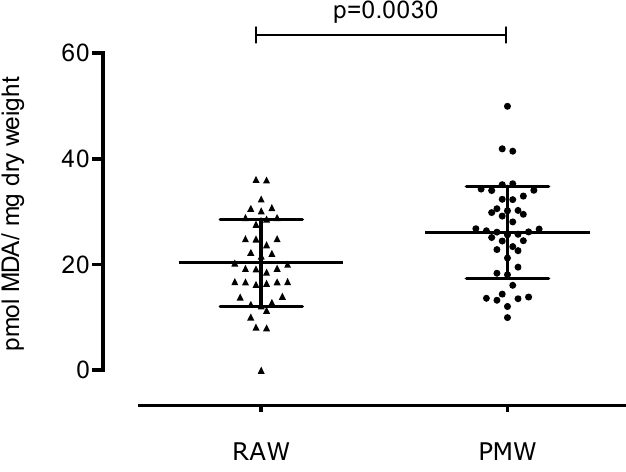
Figure 3. Levels of malondialdehyde (MDA) in reproductive-aged women (RAW) and postmenopausal women (PMW).